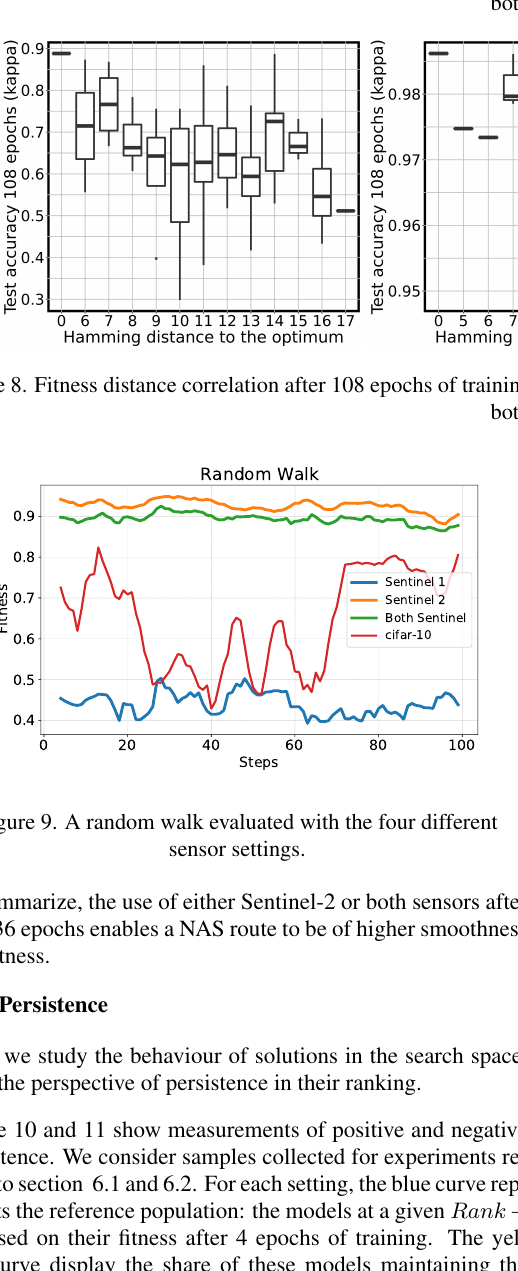
Figure 7. Fitness distance correlation after 36 epochs of training. From left to right are shown results using Sentinel-1, Sentinel-2 and both sensors.